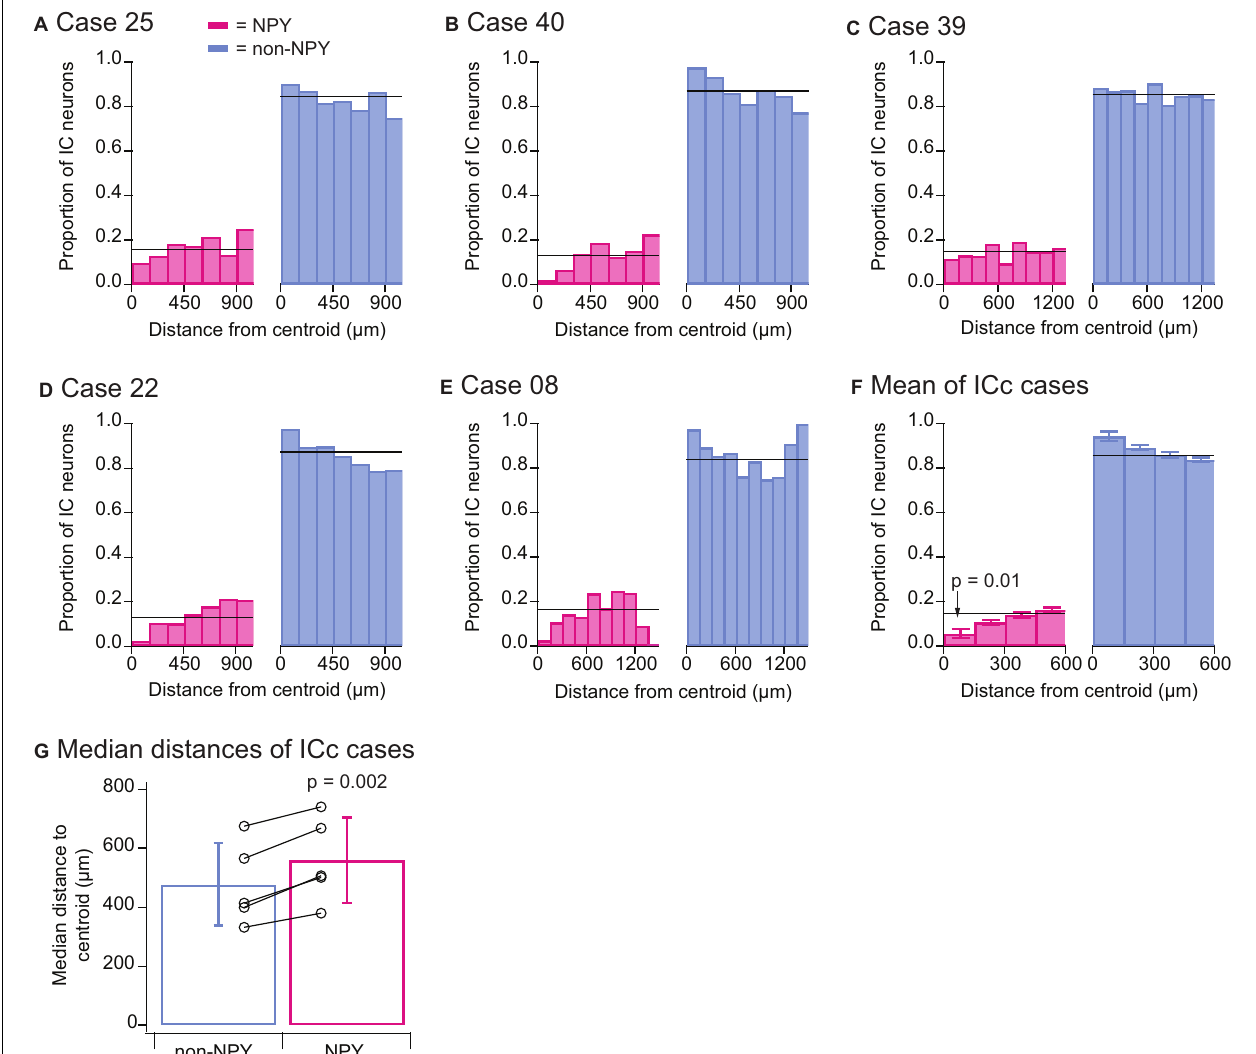
FIGURE 7 | Quantitative analysis of distances to the injection site centroid of RB-labeled neurons from all IC subdivisions. Data show results from the five ICc injection cases. Analyses are as detailed in the Figure 6 legend, except that all RB-labeled neurons in the IC were included in the analysis. The results again reveal that there were fewer RB-labeled NPY neurons within 150 µ m of the centroid (F) and that RB-labeled NPY neurons had larger median distances to the centroid than RB-labeled non-NPY neurons (G)